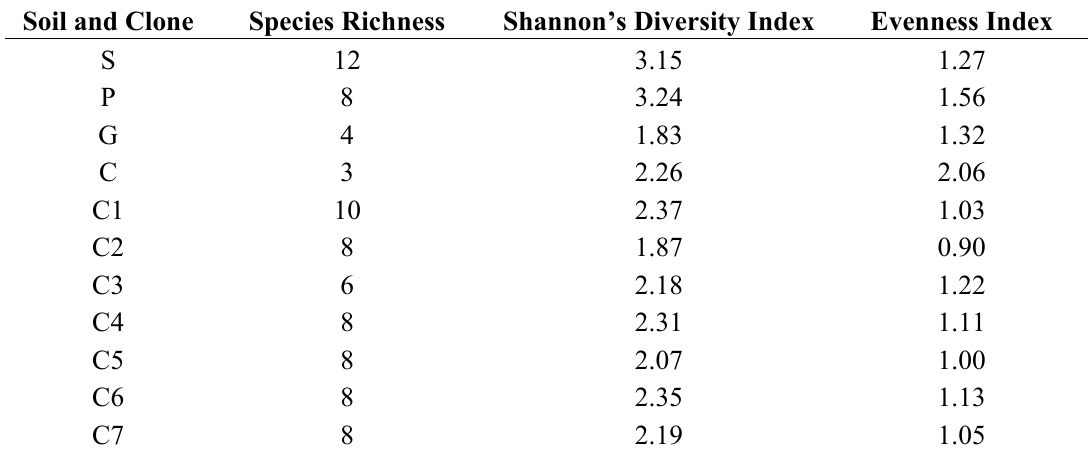
Table 1. Mean values of species richness and the ecological indexes of ectomycorrhizal communities associated with the seven poplar clone types grown in the four different former land use